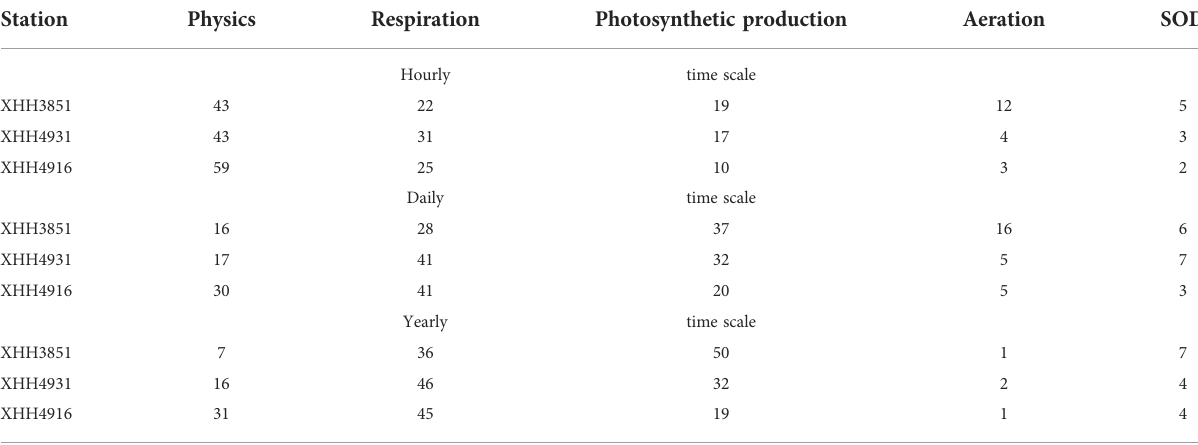
TABLE 2 Percent contribution (%) to DO budget across different time scales and stations (SOD: Sediment Oxygen Demand). Station Physics Respiration Photosynthetic production Aeration SOD Hourly time